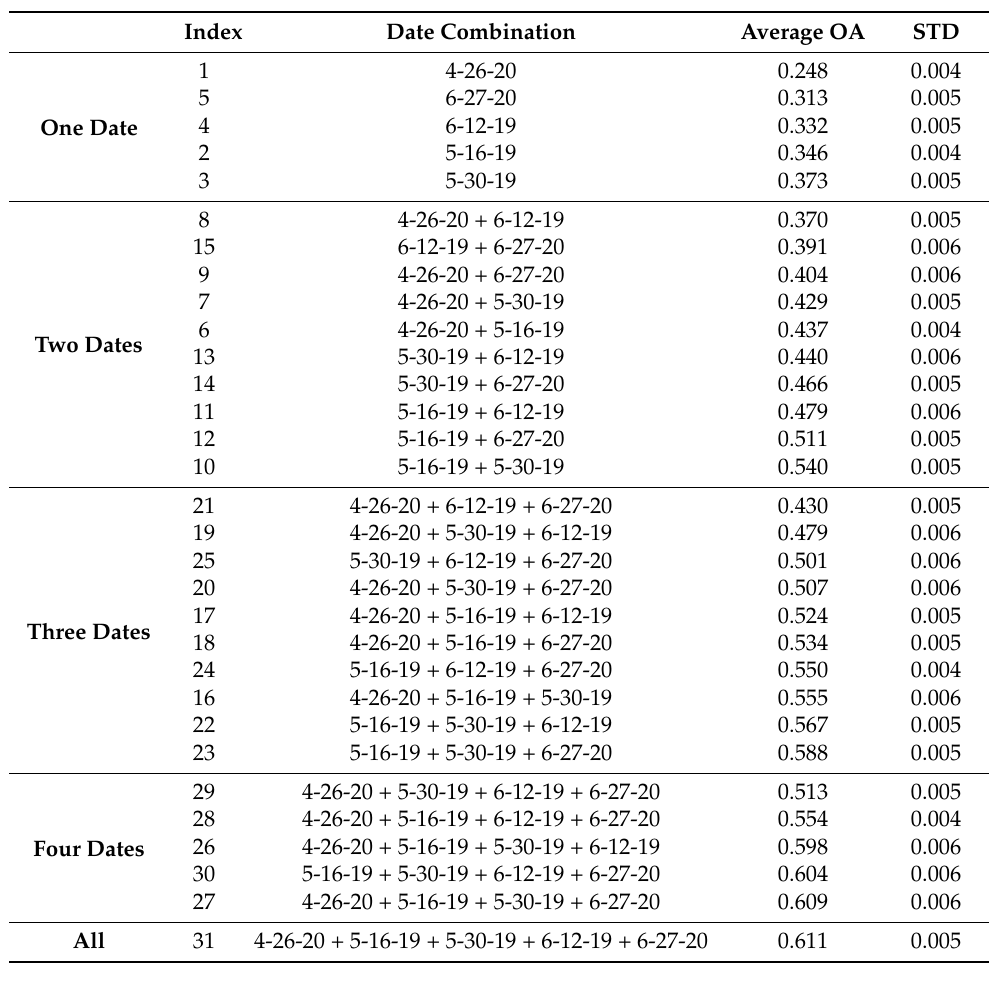
Table A1. Accuracy for all Aeria classifications. Overall accuracy (OA) is reported here as the average OA of the 30 classification iterations performed for each combination. The standard deviations (STDs) are given. The results are sorted by the number of dates included in the combination and the average